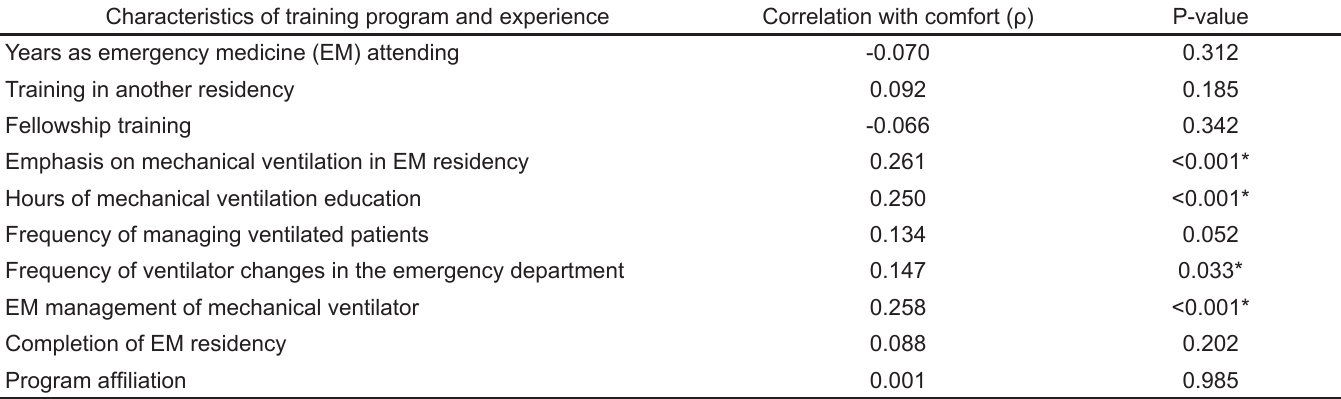
Table 3. Correlations between candidate predictor variables and attending physician comfort with managing mechanically ventilated patients.